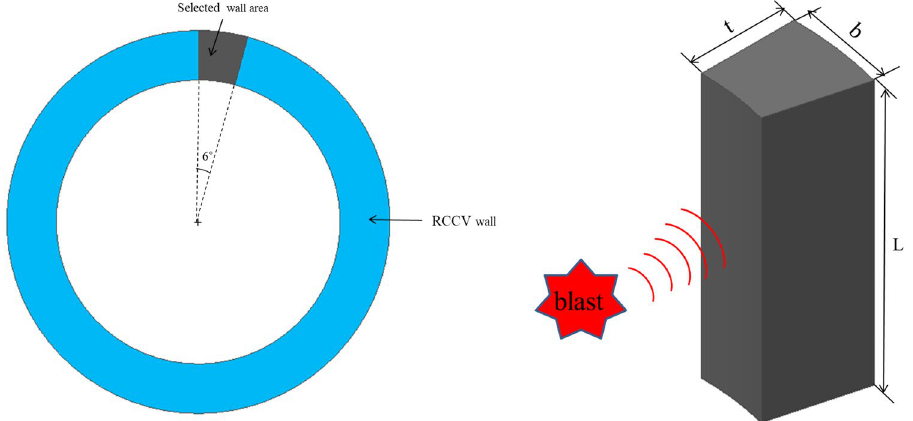
Figure 18. Moment of inertia calculation model.